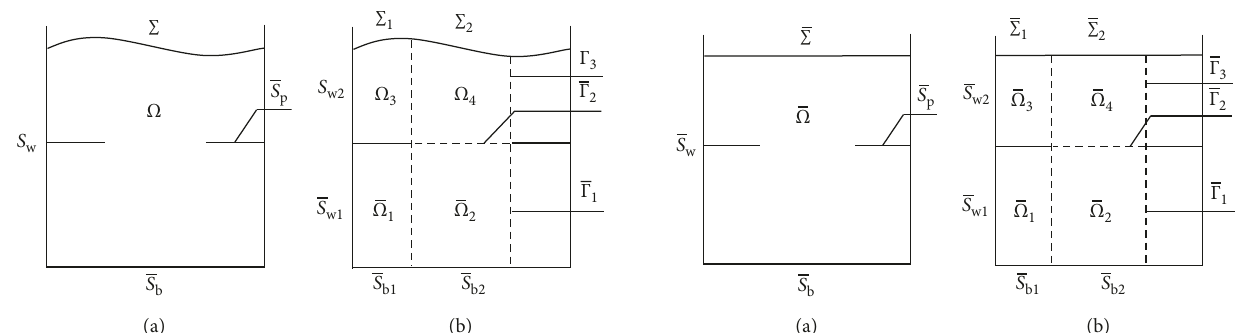
Figure 4: Cross section, subdomains, and artificial interfaces of the time-dependent liquid domain Ω .